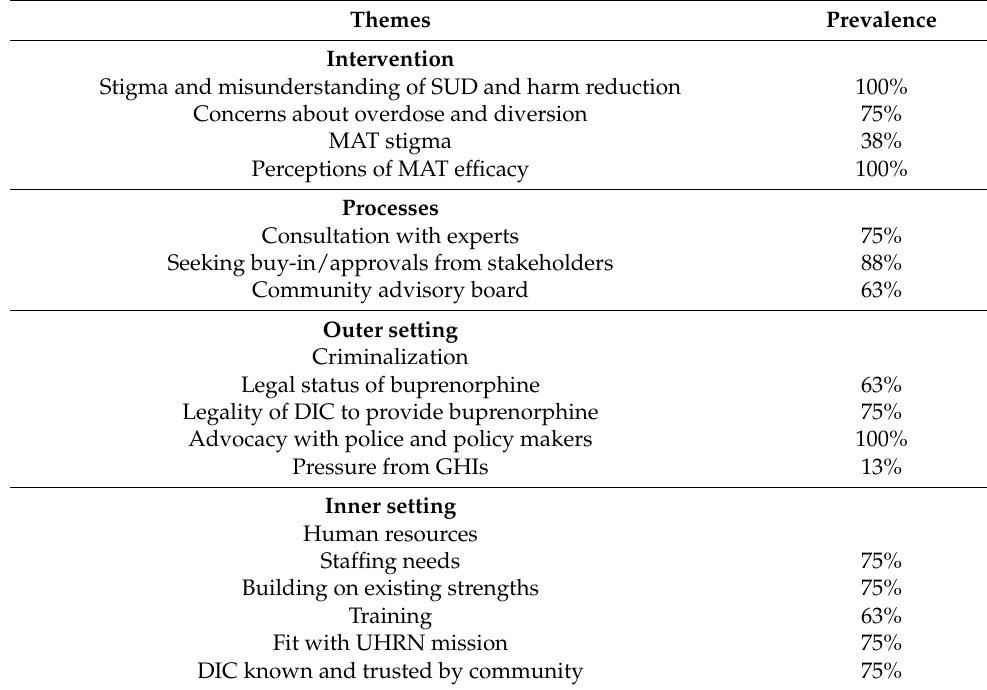
Table 1. Prevalence of themes in CFIR